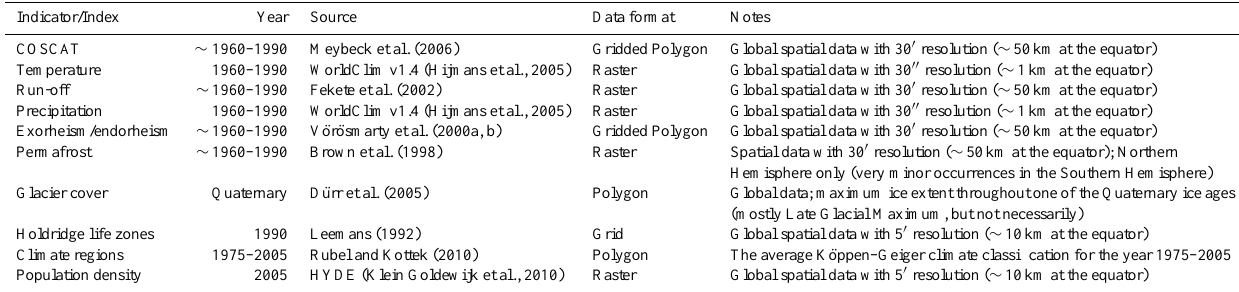
Table 2. Datasets used for the hydrobelt delineation and